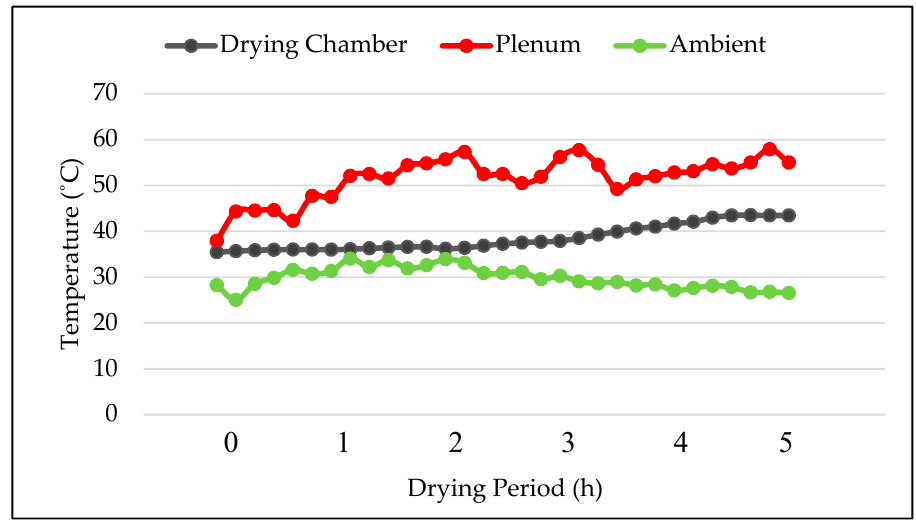
Figure 5. Temperature variations in the plenum and drying chamber during the experiment.